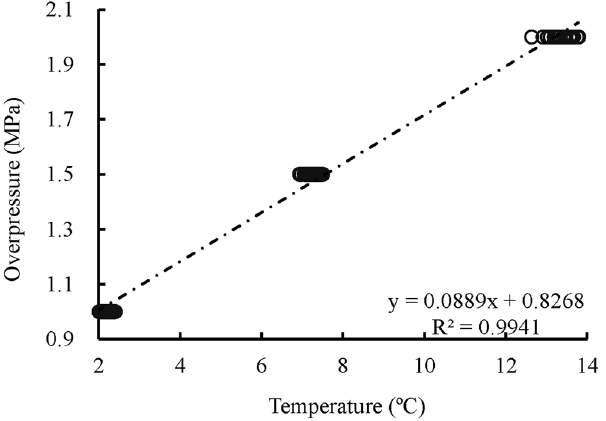
points throughout the crystallizer except at the lowest point, T4, which is shown as green line in Fig. 1a. In stage III, a sudden increase in the temperature and gas flow rate is observed. This trend is similar to that in stage I. It indicates secondary nucleation of hydrates, which was also observed by Uchida et al . 48 . In stage IV, the changes in the physical parameters are similar to those in stage II, although much shorter in duration of change, and indicate the secondary growth stage of hydrates. In stage V, the temperature and gas flow rate decrease rapidly, indicating